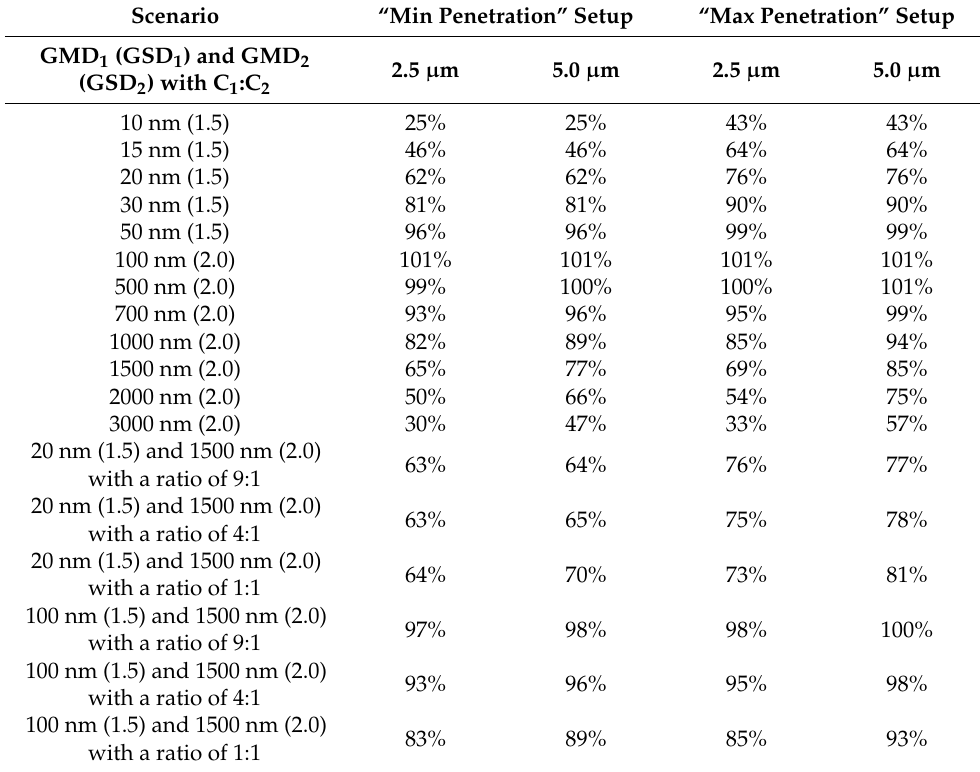
Table 2. Calculated penetrations of two PN setups (with “min penetration” and “max penetration”) using 2.5 µ m and 5.0 µ m cyclonic separators. See Table 1 for details on the different setups. Scenario “Min Penetration” Setup “Max Penetration”